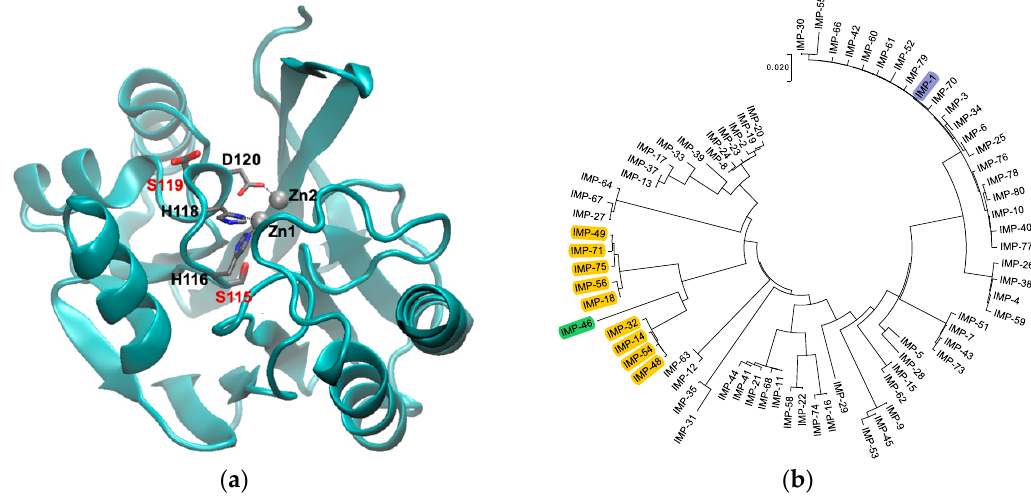
Figure 1. ( a ) Graphical representation of IMP-1 (PDB Code 1DD6 [8]) with Zn(II) shown as gray spheres and Zn(II) ligands in loop 7 as thin sticks. The two residues mutated in this study, S115 and S119, are shown as thick sticks labeled in red. Note that S119 is shown in two alternative conformations as per the crystal structure. The figure was generated with VMD [14] Version 1.9.3. The backbone is shown as a cyan cartoon. Residues are colored by atom: C, gray; N, blue; O, red. ( b ) Phylogenetic tree of the currently known IMP-type variants. Variants containing the S115T and S119G mutations studied here are highlighted in yellow, the IMP-1 reference enzyme in blue, and variant IMP-46 harboring S115T in combination with S119D in green. The tree was generated with MEGA [15] Version 7.